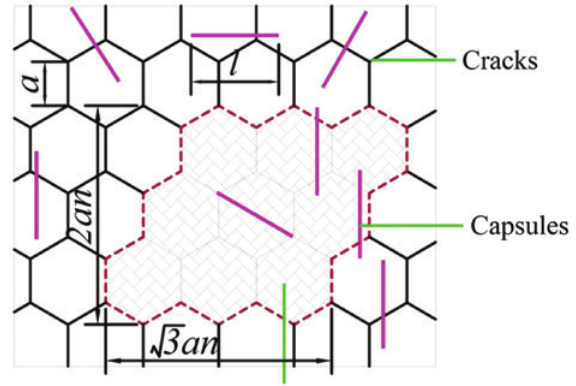
Figure 4: Rhombic crack pattern and a representative sampling region E 2.